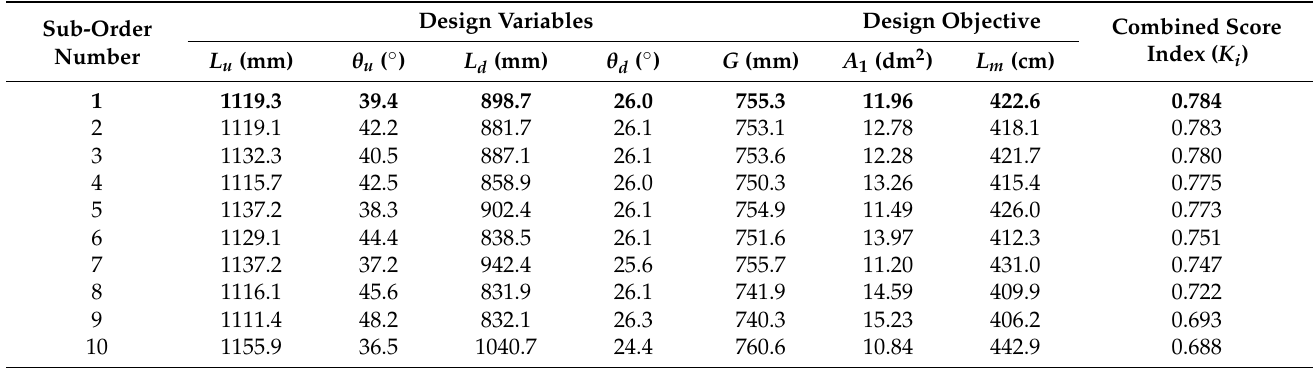
Table 2. Top 10 Pareto optimal solutions after TOPSIS ranking.